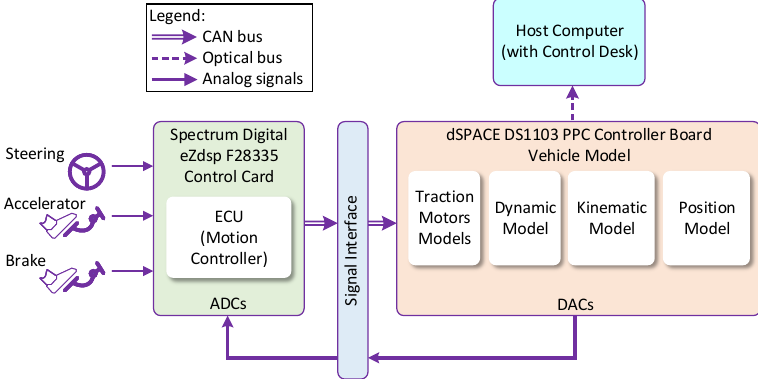
Figure 2. Configuration of the proposed Hardware-in-the-loop simulation